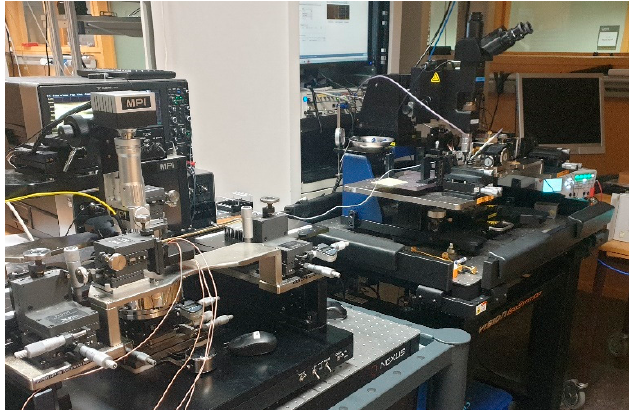
Figure 15. Measured group delay of the fiber that was used during the measurements.